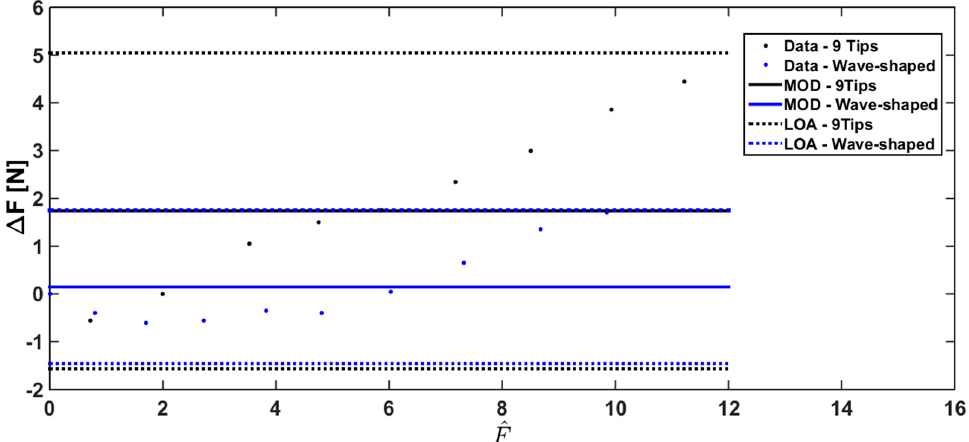
Figure 11. Bland Altman analysis comparing (cid:1832) (cid:3040) with (cid:1832) (cid:3045) for the two loading conditions under human-like grasping conditions (data related to 9 Tips load, and Wave-shaped load are shown in black and in blue, respectively).